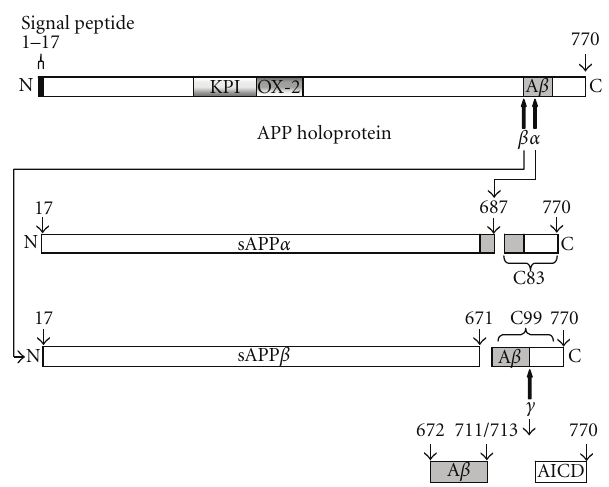
Figure 1: Proteolysis of the amyloid precursor protein (APP). APP can be cleaved by two alternative proteolytic pathways, the amyloidogenic and nonamyloidogenic pathways. It is the balance between these two pathways which dictates the levels of A β -peptides generated. KPI: Kunitz-type serine proteinase inhibitor domain; OX-2: OX-2 domain; A β : amyloid beta; AICD: APP intracellular